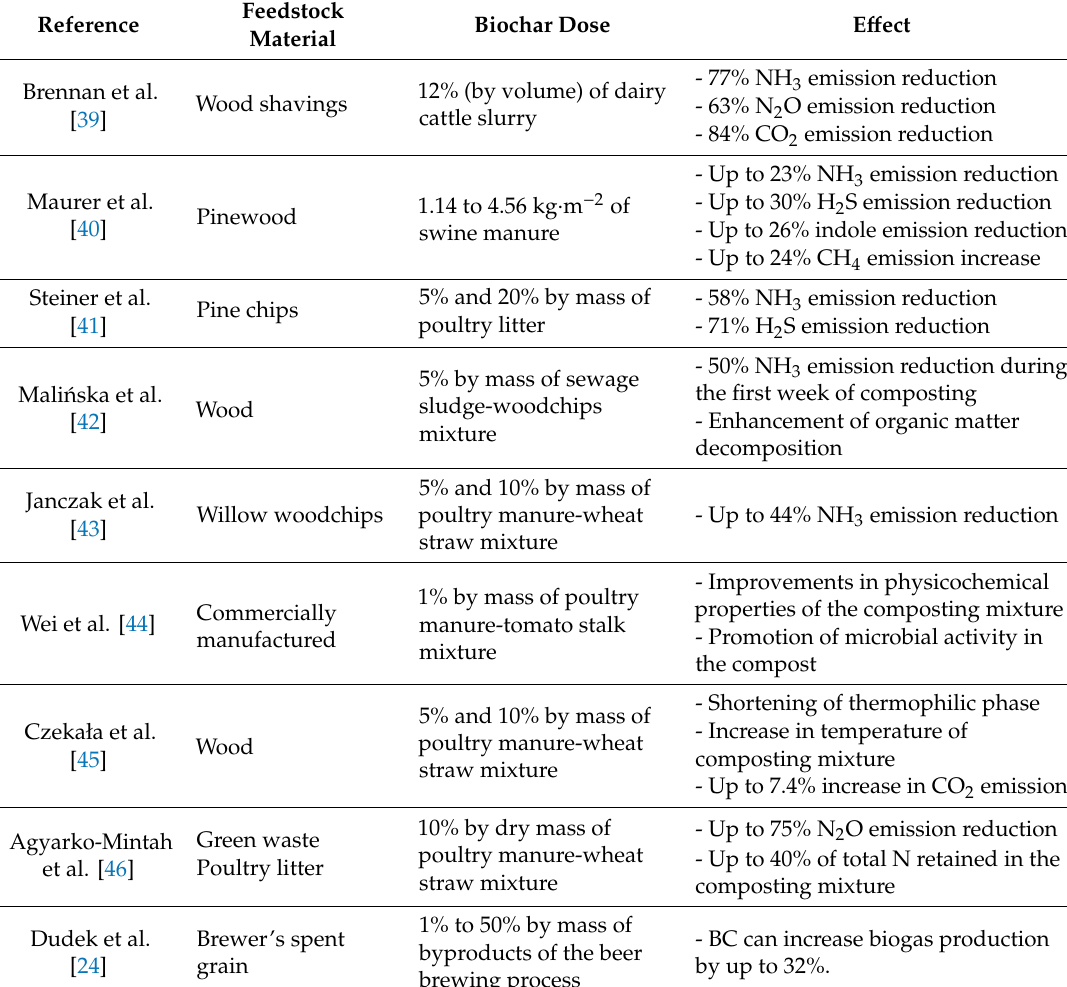
Table 3. Summary of selected data on biochar application to waste for reduction of gaseous